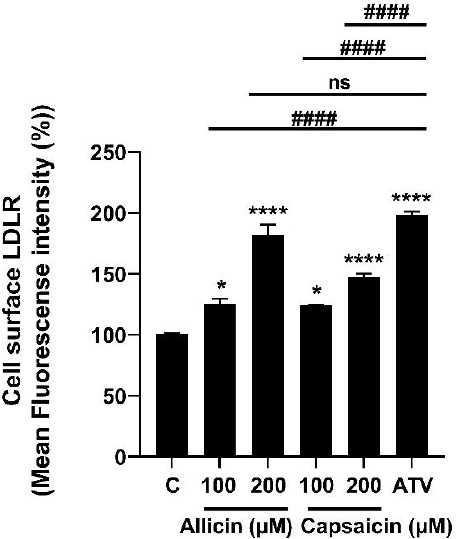
Figure 4. Effects of allicin (100 µM and 200 µM), capsaicin (100 µM and 200 µM), and atorvastatin (10 µM) on LDLR expression in HepG2 cells . HepG2 cells were treated with allicin (100, 200 µM), capsaicin (100 µM, and 200 µM), or atorvastatin (10 µM) for 24 h, and the level of cell-surface LDLR expression was measured by flow cytometric analysis. The data represent the mean ± SEM of three independent experiments ( N = 3). * p < 0.05, and **** p < 0.001, represent significant differences com- pared to the vehicle-treated cells or the control group (C). #### p < 0.001 represents significant differ- ences compared to atorvastatin (ATV)-treated cells. ns: not significant.